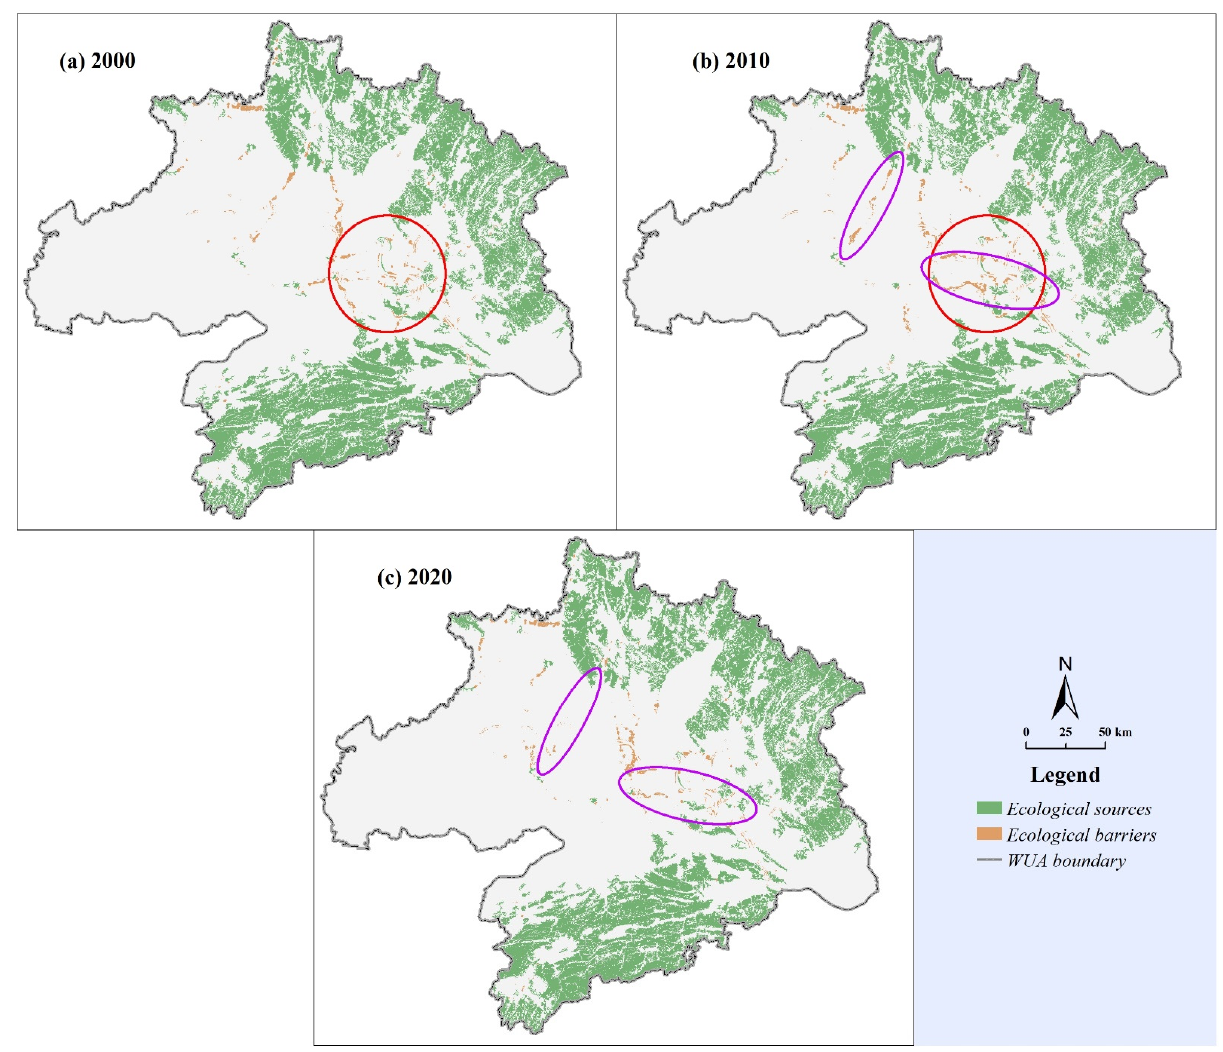
Figure 6. Spatial distribution of ecological barriers in 2000, 2010, and 2020. Table 3 . Composition of land use types for ecological barriers in 2000, 2010, and 2020.